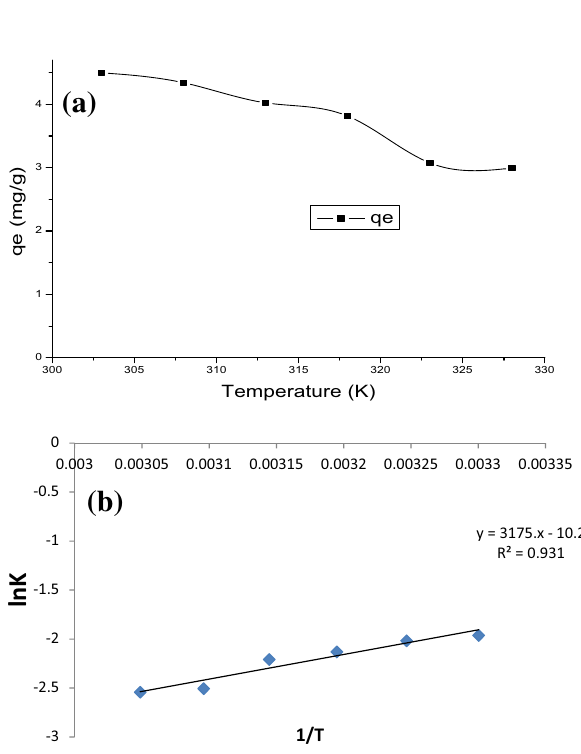
Fig. 5 a Effect of temperature on the sorption of BPA onto nFe Thermodynamic plot